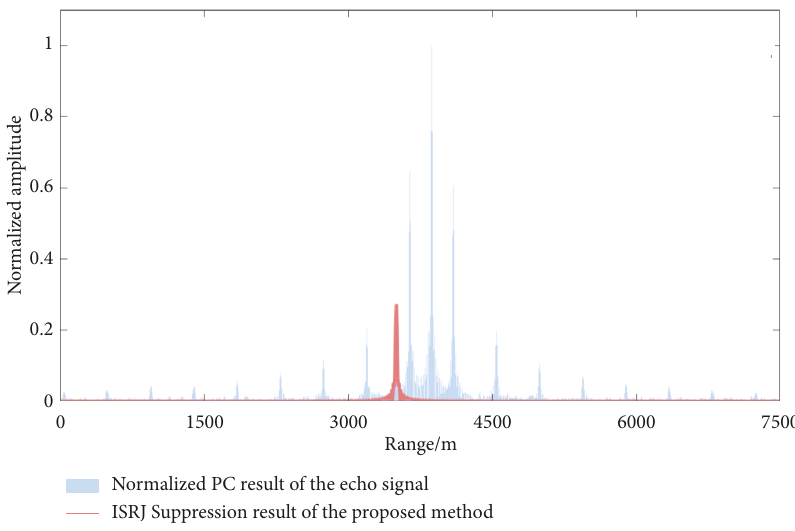
Figure 13: ISRJ suppression results in the target aliasing